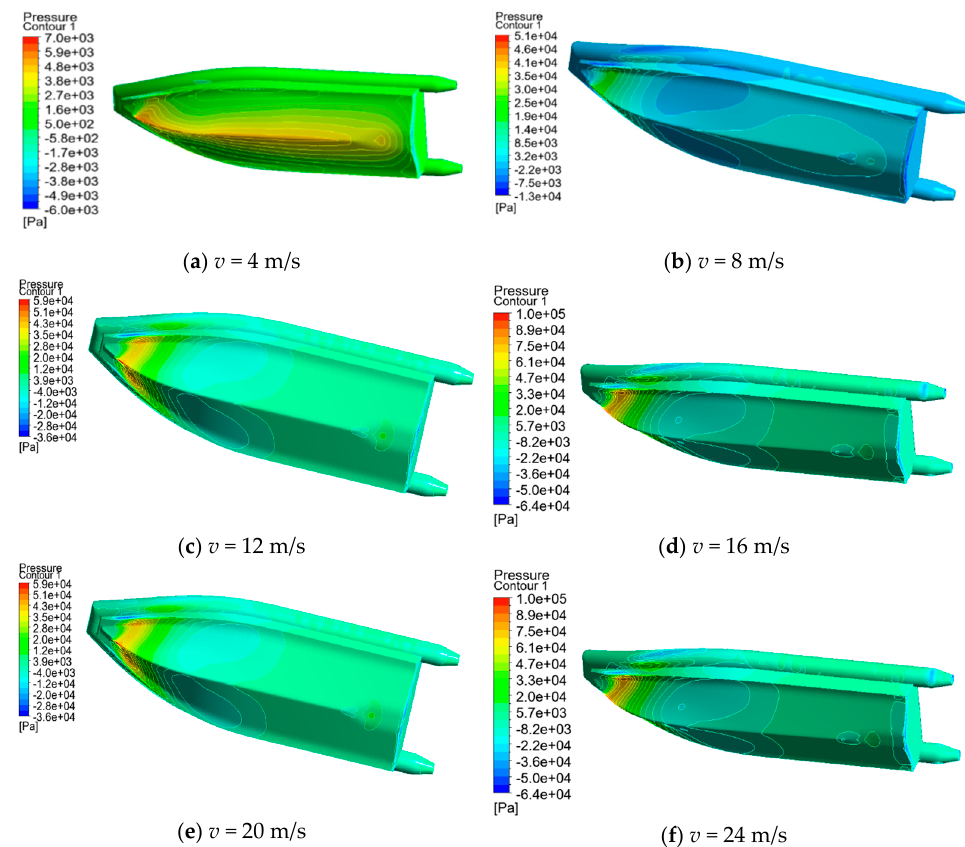
Figure 9. The bottom pressure characteristics of the unmanned ship at different speeds.